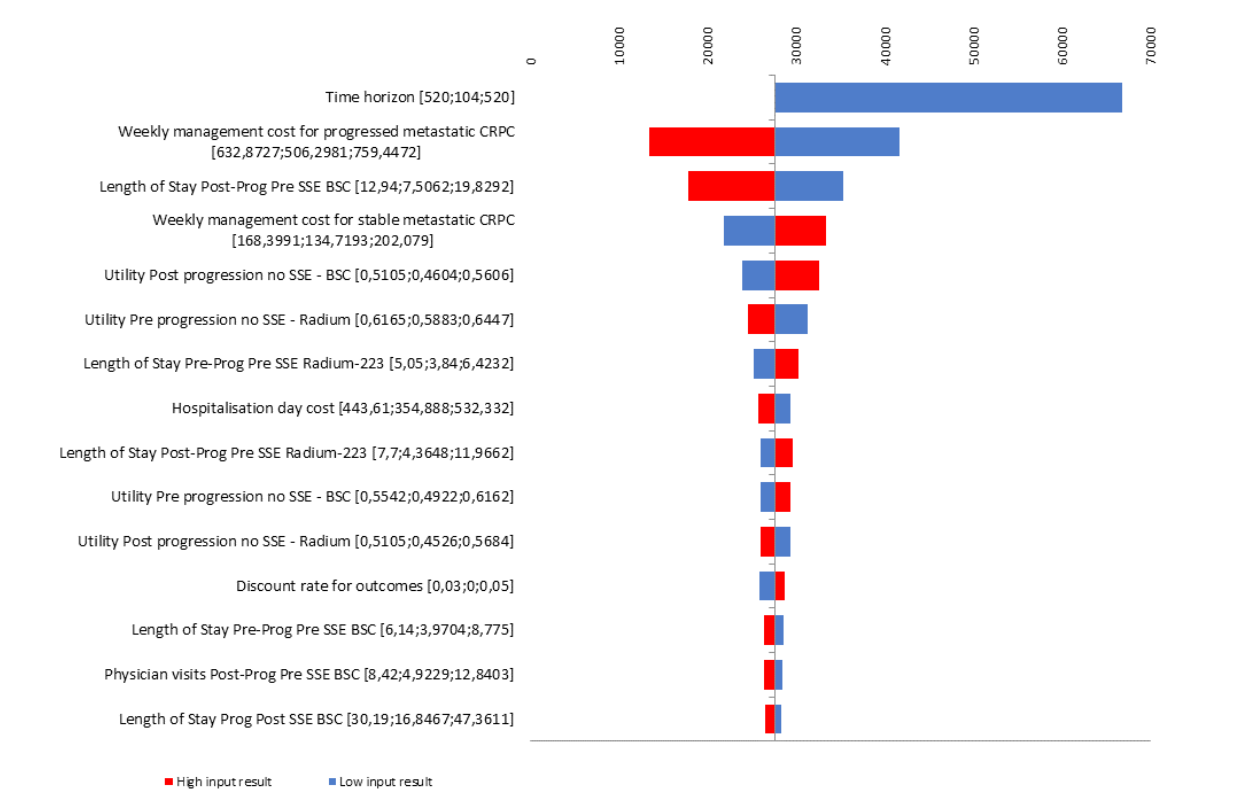
Figure 2. One-way Sensitivity Analysis, Tornado Diagram